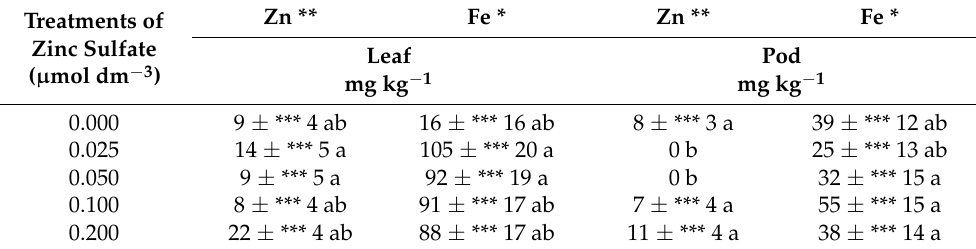
Table 2. Average micronutrient content of Zn and Fe in foliar tissue and bean pod, due to zinc application in different